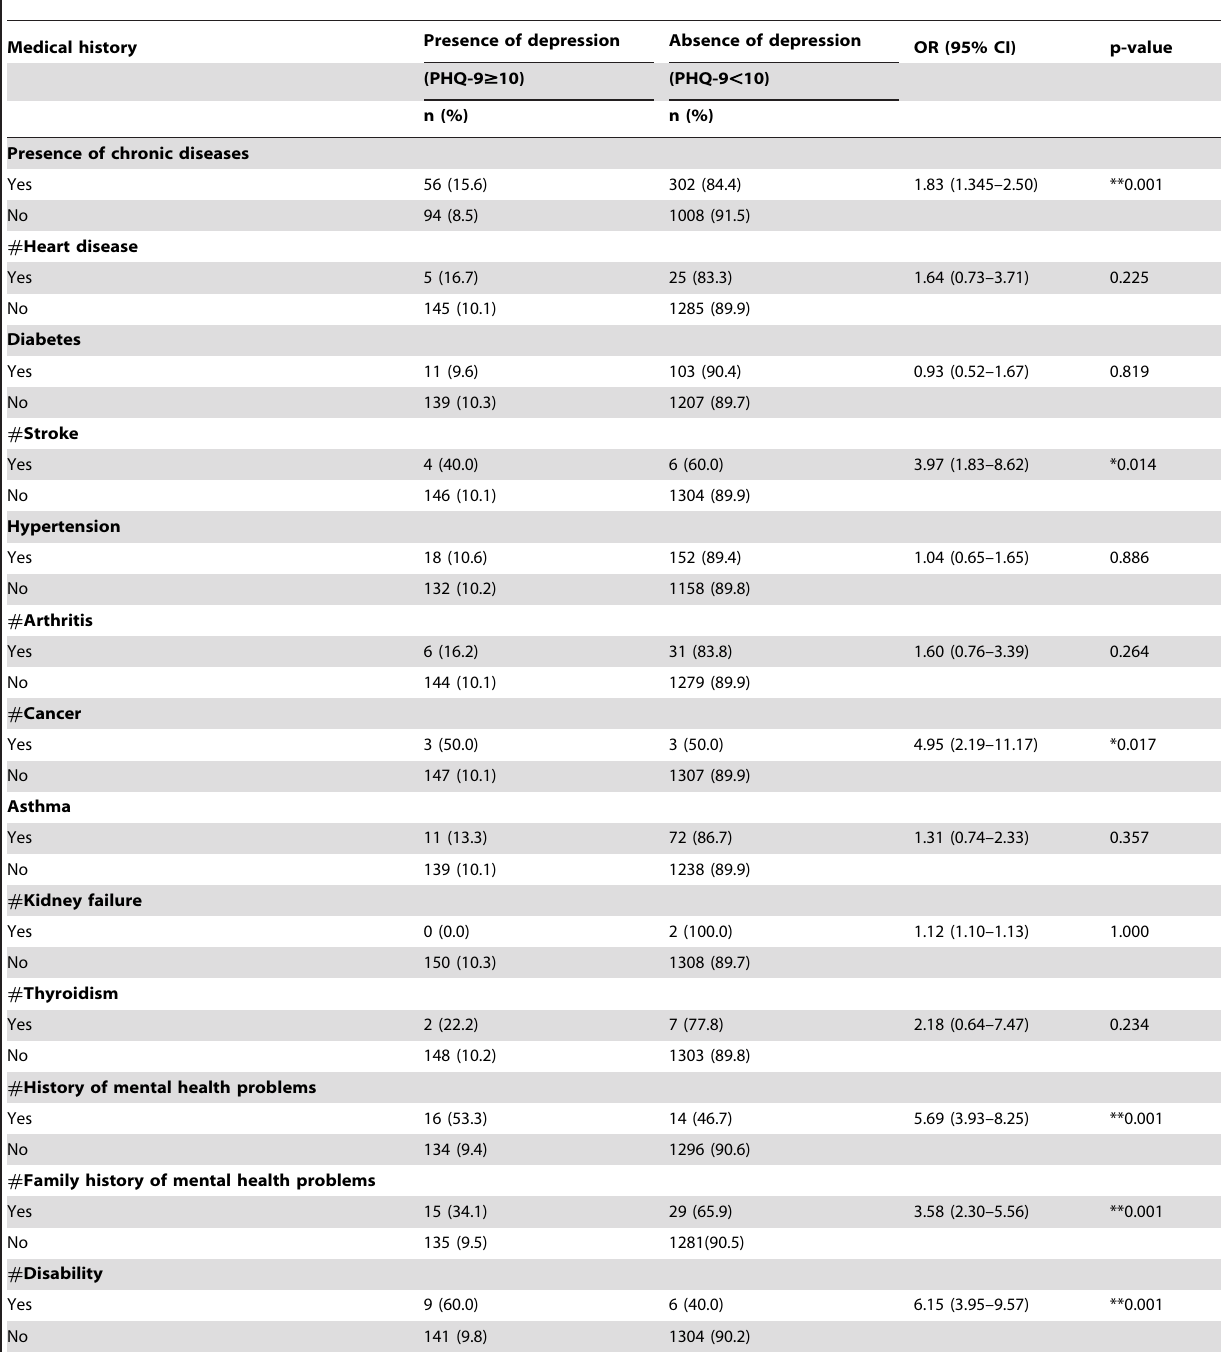
Table 2. Association of chronic diseases and history of mental health problems with depression among participants (n= 1460).